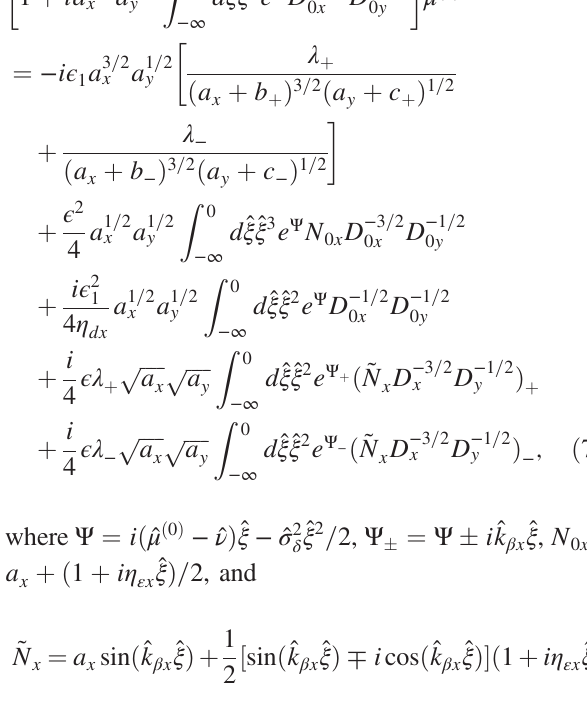
TABLE I. Undulator and electron beam